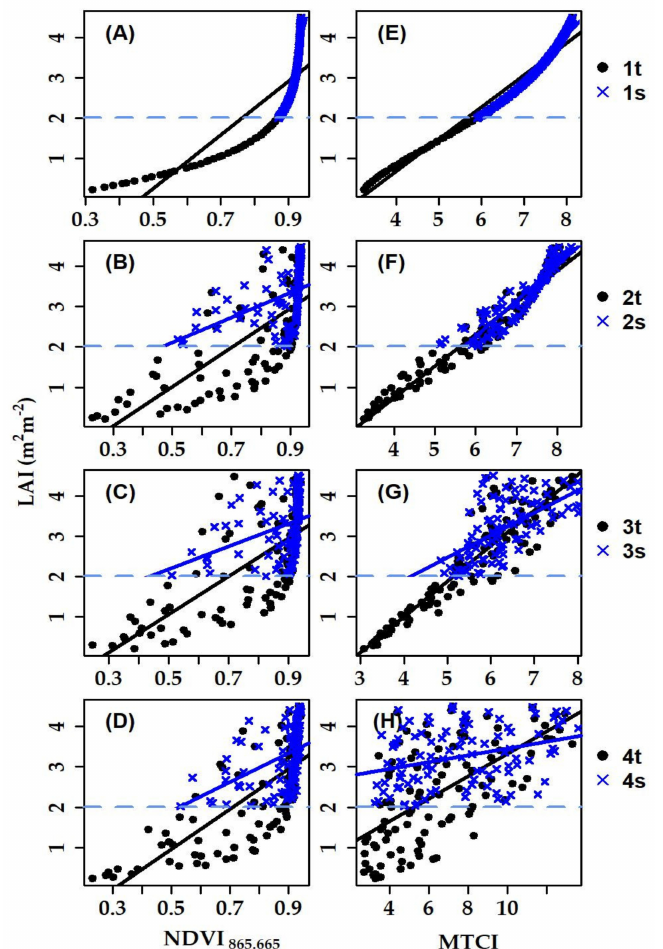
Figure 10. Relationships between VIS-NIR indices and LAI for all eight scenarios for both temporal (( A , E ) 1t; ( B , F ) 2t; ( C , G ) 3t; and ( D , H ) 4t) and spatial scale observations (( A , E ) 1s; ( B , F ) 2s; ( C , G ) 3s; and ( D , H ) 4s). The horizontal dashed line represents the minimum value of LAI when PROSAIL was run using spatial observation LAI ranges as input parameter. In all panels, solid lines represent a linear fit to the